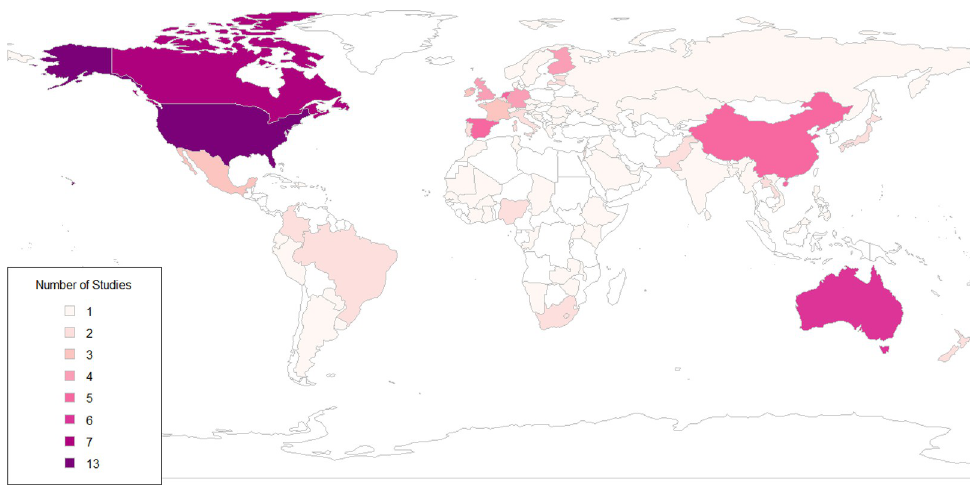
Fig 1. Number of studies on MDD treatment coverage by country. Note: created using open-source software R version 4.1, using the rworldmap package. MDD, major depressive disorder.